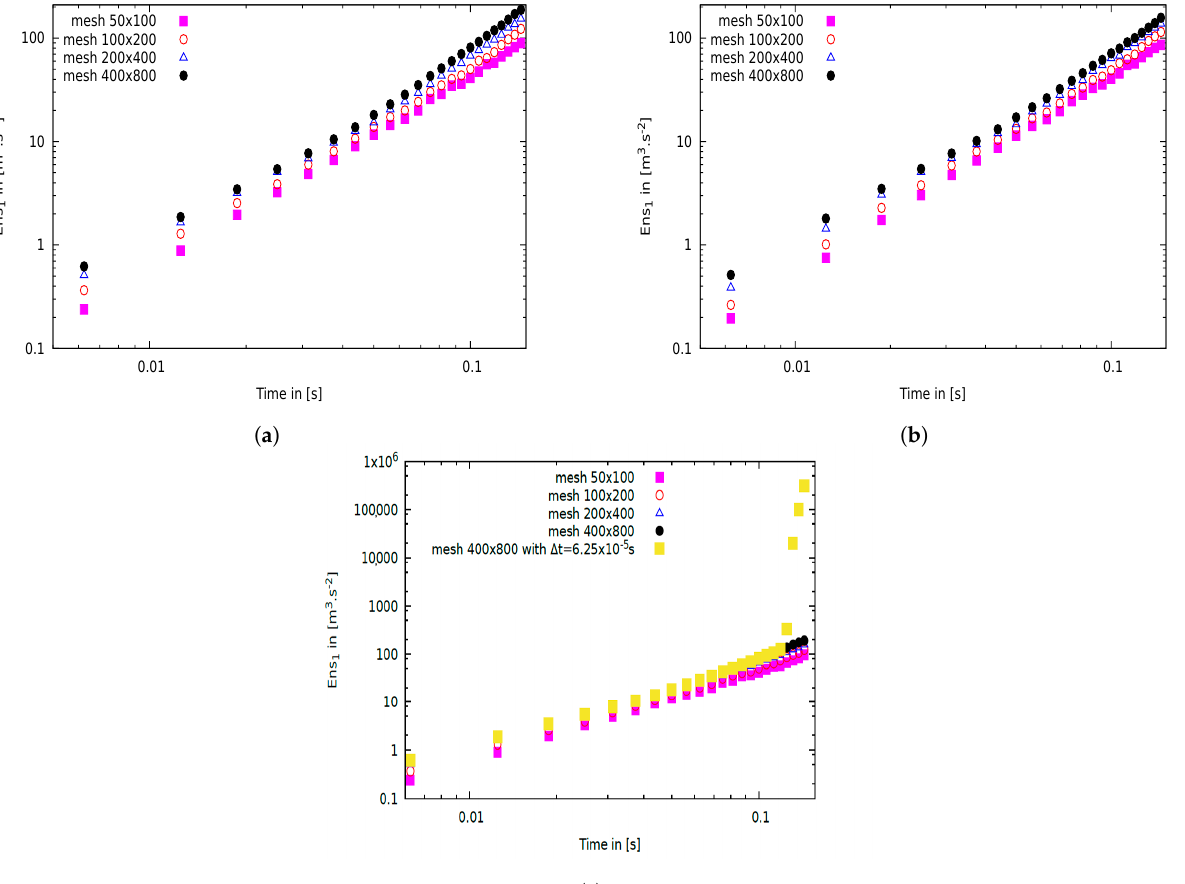
Figure 4. Time evolution of enstrophy in fluid 1 for the free fall of dense cylindre case. Obtained by several numerical methods with several Cartesian mesh. ( a ) FC method, ( b ) AAL method and ( c ) SP